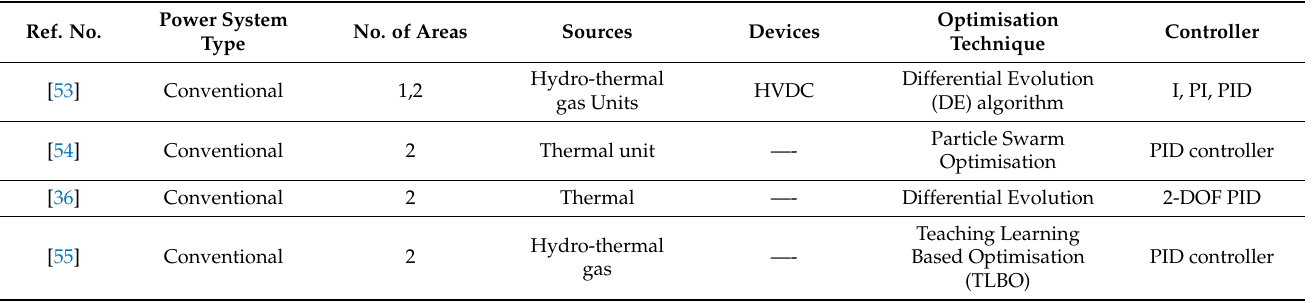
Figure 2. Generalised diagram of two area LFC of reheat thermal-based power system. Table 3. Comparison of latest strategy applied for LFC in the different power system models. Ref.